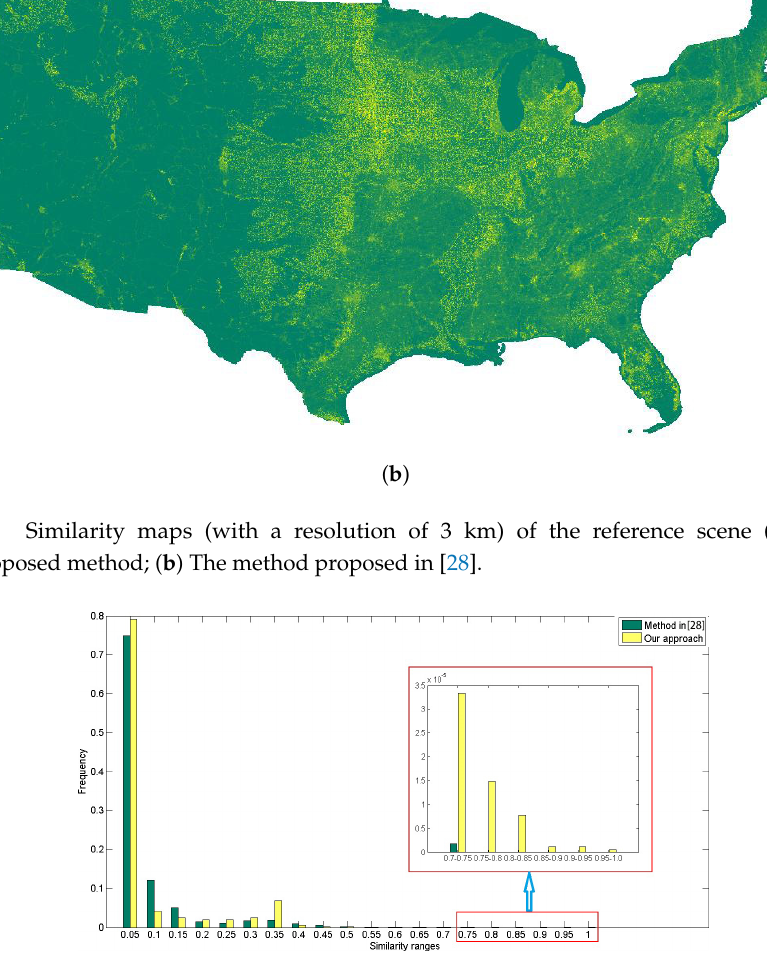
Figure 24. Comparison chart of the similarity histograms for the reference scene (Figure